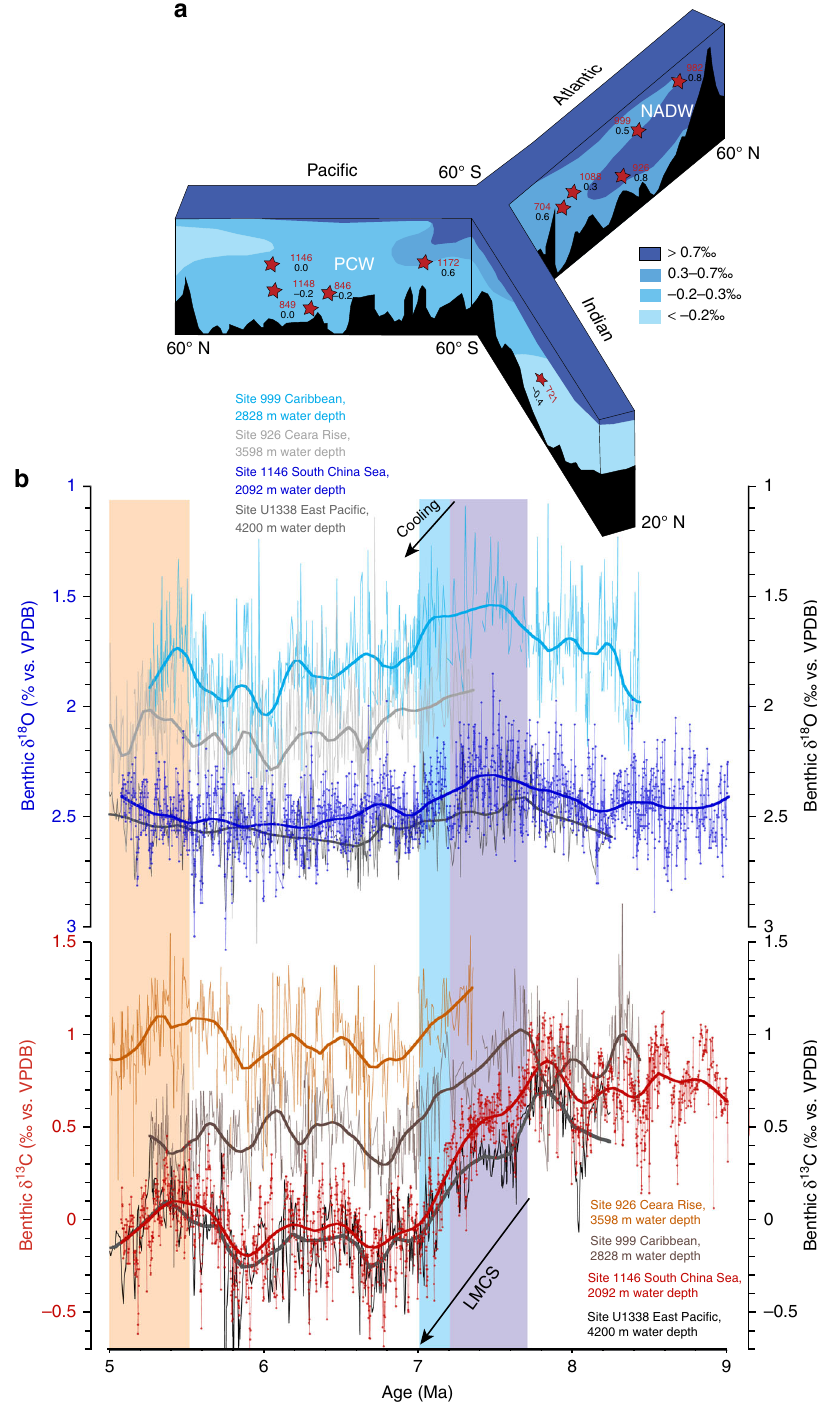
Fig. 6 Comparison of late Miocene inter-basinal benthic δ 18 O and δ 13 C gradients. a Vertical distribution of δ 13 C in world ’ s oceans following late Miocene δ 13 C shift. Averaged values over interval 7 – 5 Ma for key sites in the Paci fi c, Atlantic, Indian, and Southern Oceans compiled from refs. 22,54,55,76, NADW: North Atlantic Deep Water, PCW: Paci fi c Central Water. b Late Miocene evolution of inter-basinal benthic δ 18 O and δ 13 C gradients: comparison of Paci fi c ODP Site 1146 and Atlantic ODP Sites 926 and 999 22,23 and equatorial Paci fi c IODP Site U1338 55 over interval 9 – 5 Ma. Stable isotope data from Sites 926 and 999 are plotted on originally published age models. Over the interval 8.2 – 7.5 Ma, the Site U1338 age model was adjusted to that of Site 1146 by tuning the δ 13 C records. Lilac shading marks global δ 13 C decline coincident with planktic δ 18 O increase and high-amplitude obliquity modulation of benthic δ 18 O. Blue shading marks fi nal stage of global δ 13 C decline. Light orange shading marks climate warming after 5.5 Ma. Smooth curve in b fi tted using locally weighted least squared error (Lowess)